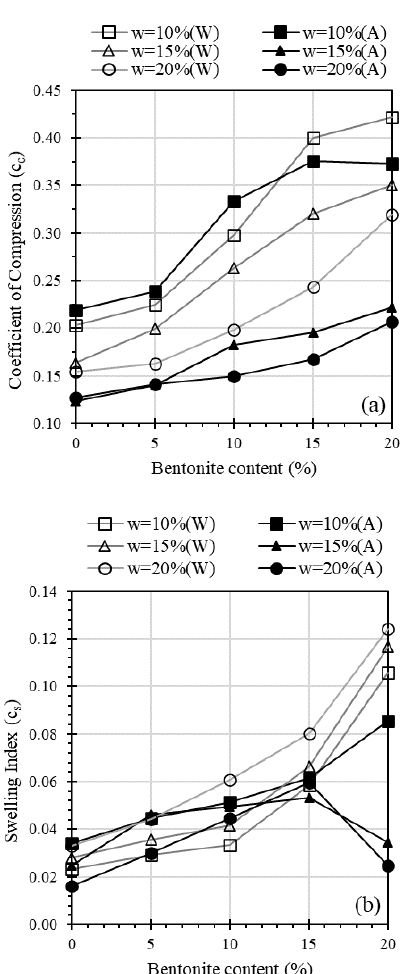
Fig. 7. Effects of acidic water on the compression parameters as a function of bentonite content (a) Coefficient of compression, and (b) swelling index.